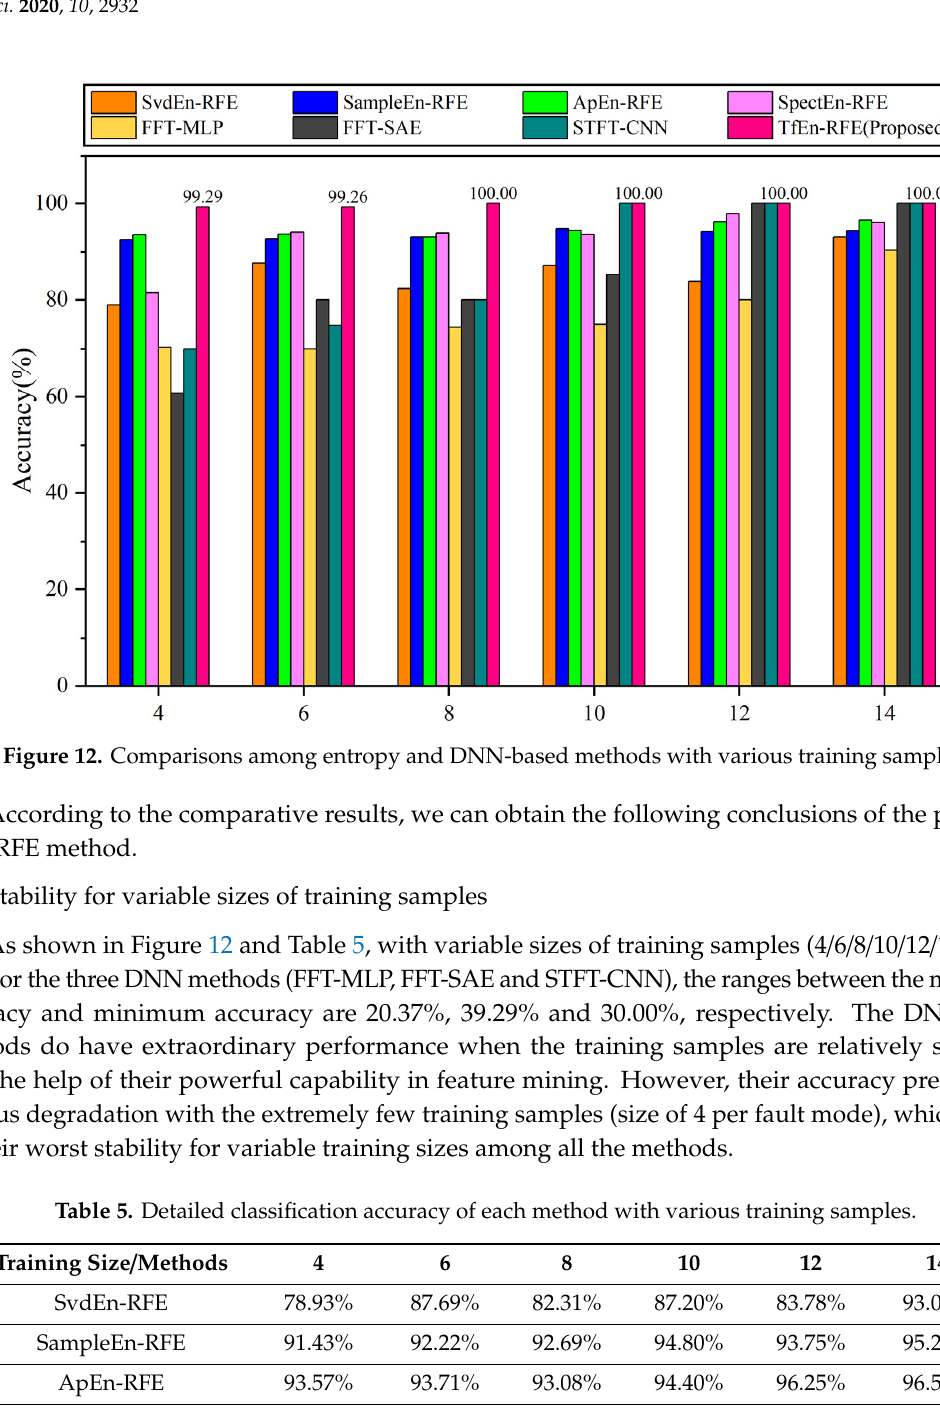
Table 5. Detailed classification accuracy of each method with various training samples.